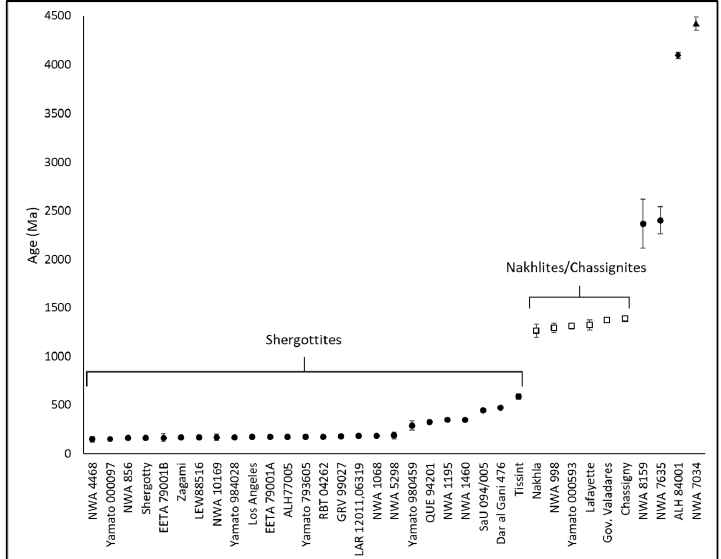
Figure 1. Crystallization ages of shergottites (black circles), nakhlites and chassignites (white squares), Northwest Africa (NWA) 7034 (black), Allan Hills (ALH) 84001 (black diamond), and NWA 7034 (black triangle). The age shown for NWA 7034 corresponds to the oldest measured igneous clasts. Data are from [11,12,19,22,27,28] and references